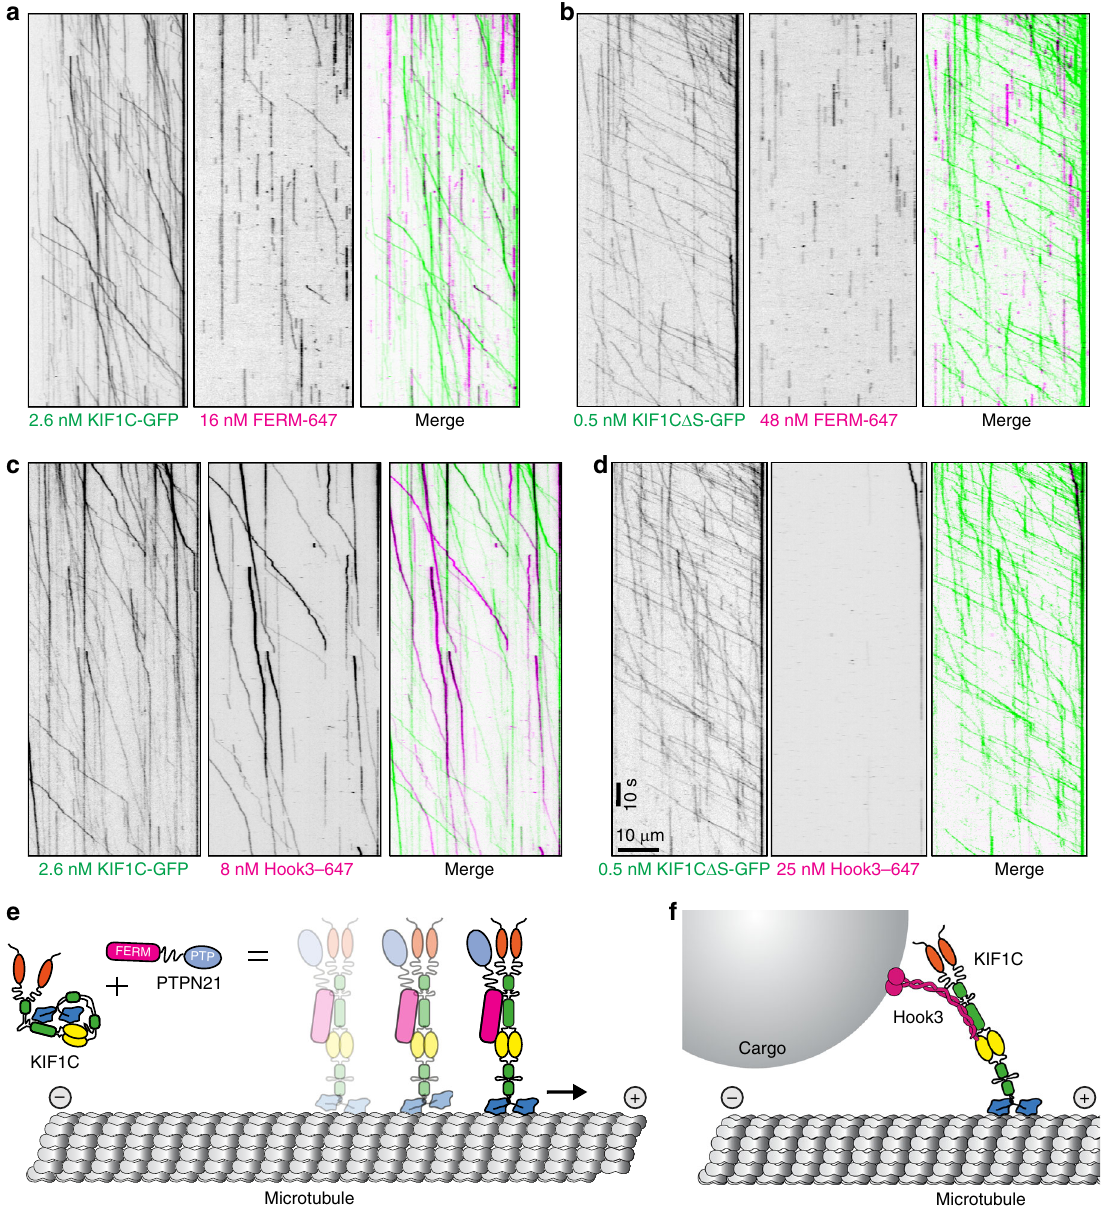
Fig. 8 Activation and cotransport with KIF1C. a – d Both PTPN21-FERM domain and Hook3 cargo adapter are co-transported with KIF1C if the stalk domain is present. e , f Model for KIF1C activation. KIF1C is an autoinhibited dimer in solution. Intramolecular interactions between stalk and motor domain prevent the inhibited motor from interacting with microtubules. Upon binding of PTPN21, the intramolecular interactions are released, KIF1C can engage with microtubules and will step processively towards the plus end. The cargo adapter Hook3 also binds to the stalk of KIF1C and activates it, thereby mediating cargo-activated transport along